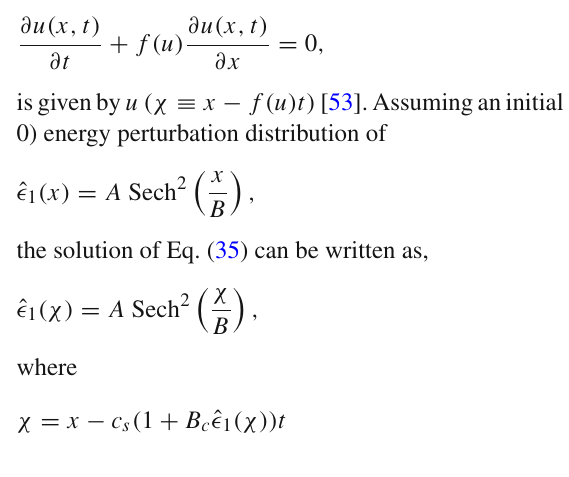
Fig. 2 Solutions of Fig. 1 at different times on a two-dimensional plot. A = 2 . 5, B = 0 . 5 f m , q = 1 . 08, and T = 140 MeV